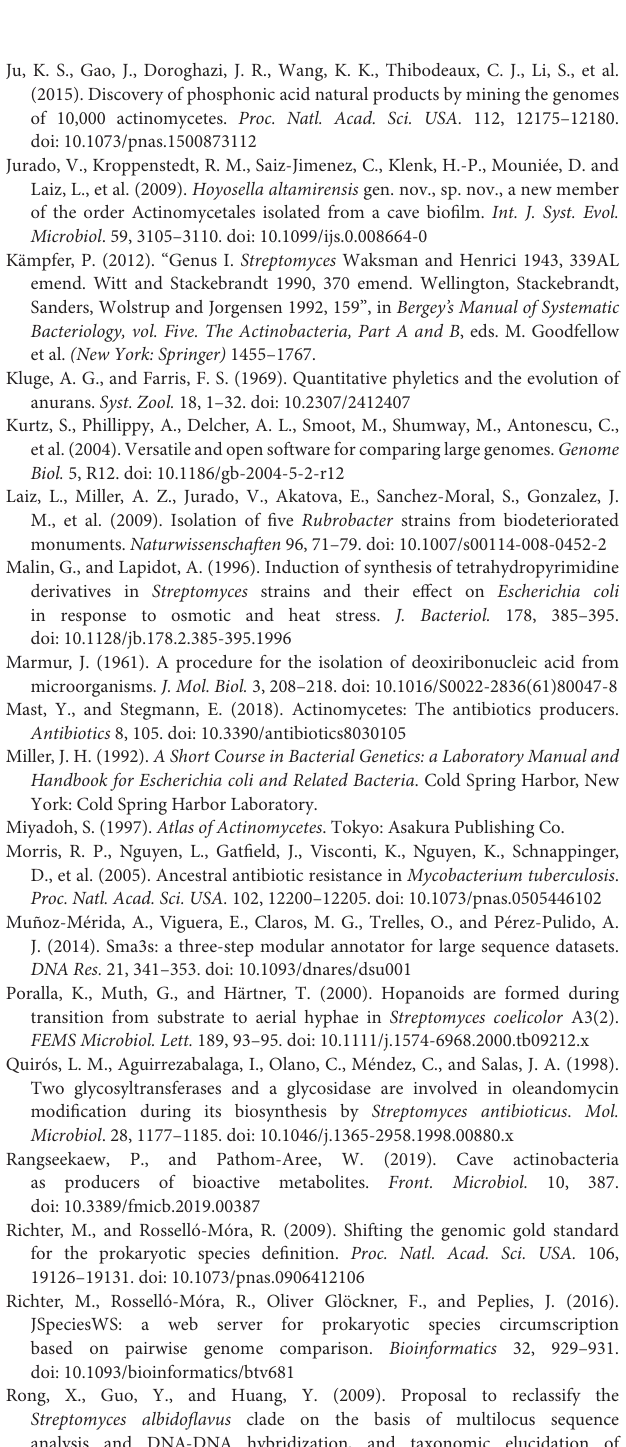
Cationic antimicrobial Peptides. (2) Tetracyclines, macrolides, lincosamides, and aminoglycosides (Morris et al., 2005). (3) Tylosin and erythromycin (Quirós et al., 1998). (4) Only present in MZ03-37 T . Supplementary Table S4 | Secondary metabolites predicted for MZ03-37 T and MZ03-48 by anti-SMASH. Gene clusters predicted without reference to the